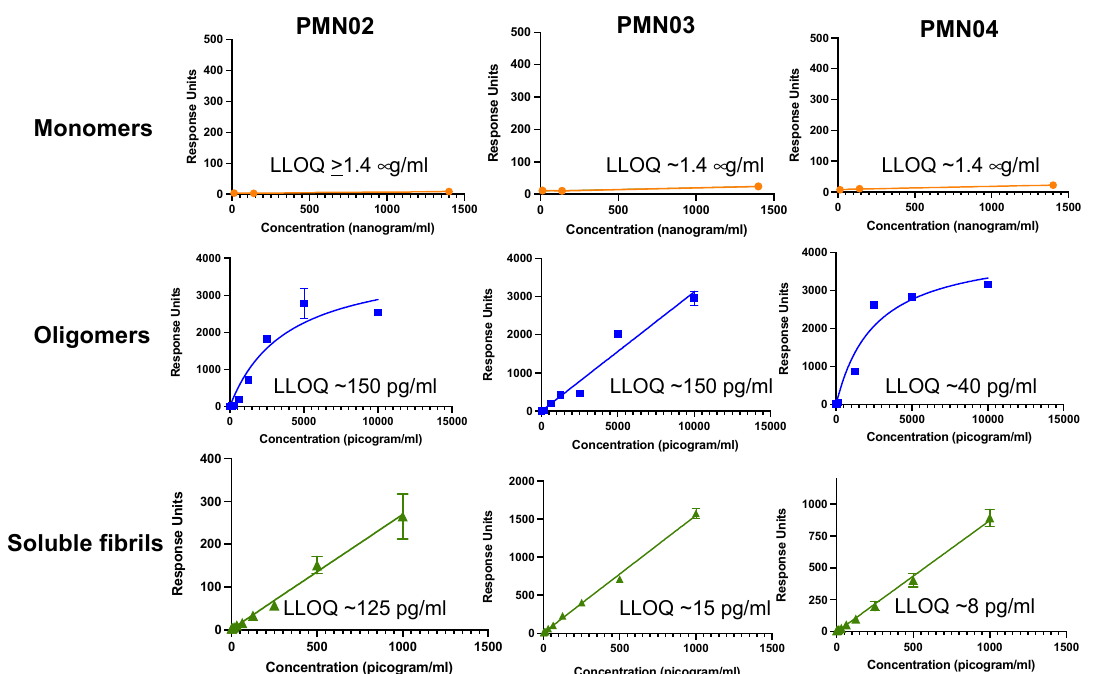
Figure 3. Selectivity of mAbs for pathogenic species of α -syn. The binding response of mAbs to various concentrations of α -syn monomers, toxic oligomers and soluble fibrils (sonicated PFFs) was measured in a Millipore immunoassay. Mean ± SD of triplicates shown with the calculated lower limit of quantitation (LLOQ) for each species.